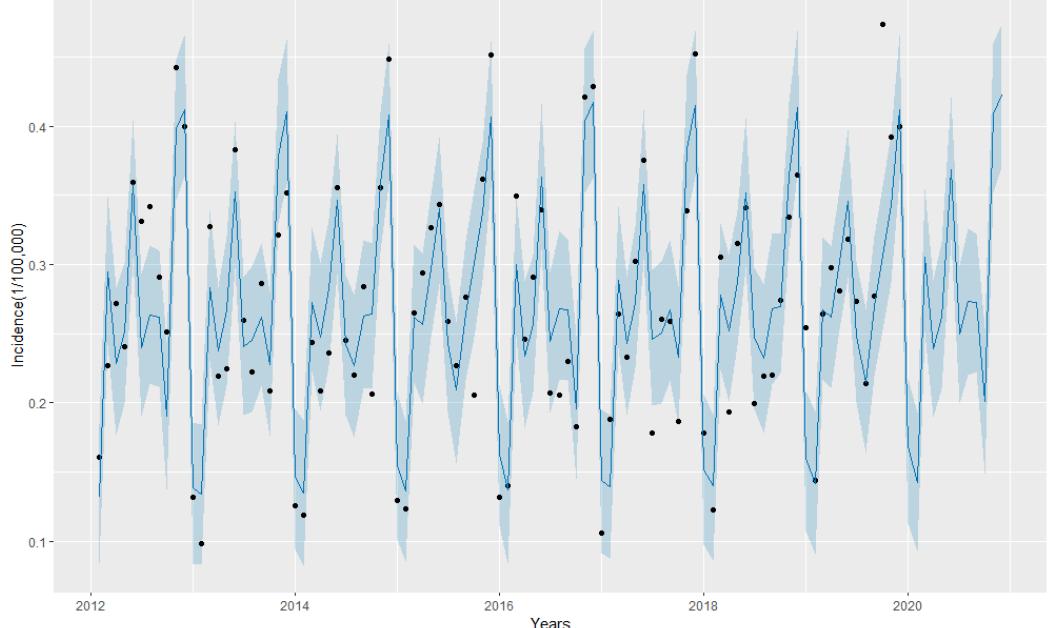
Figure 4. Predicted new infection rate of AIDS from January 2012 to December 2020 by Prophet model. The black dots represent the observed values, the blue line represents the fitted or predicted data of Prophet model, and the shadow area represents 95% confidence intervals.